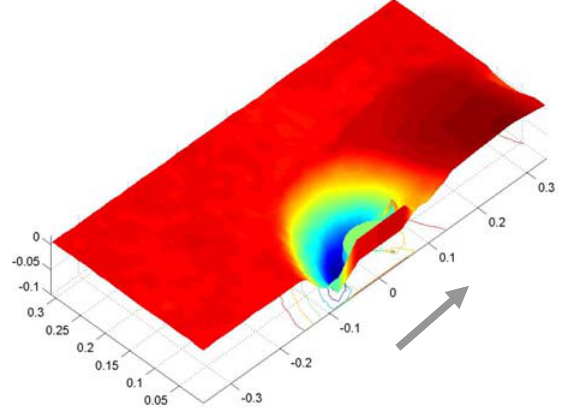
Figure 8. DEM after one hour. Flow is from lower left to upper right.